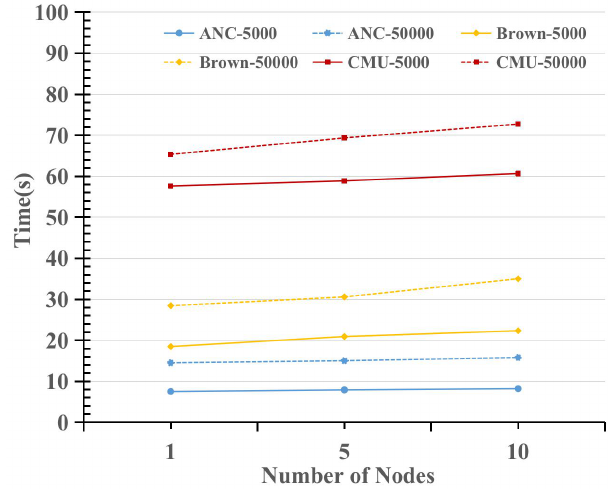
Figure 11. The time of remote update in B+Tree (256